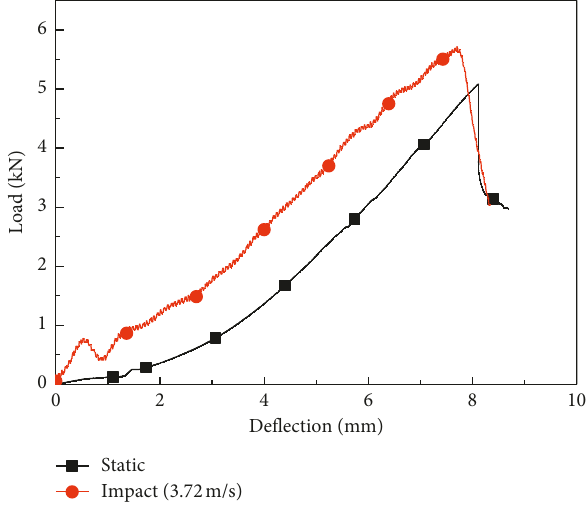
Figure 4: Load-deflection curves of 2/1 BFMLs.